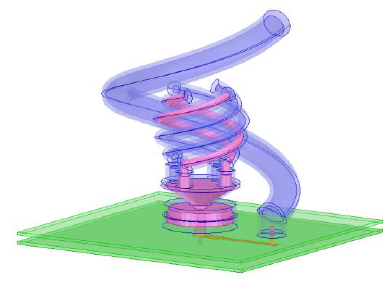
Figure 19. Diagram of State-IV with liquid metal filled in.